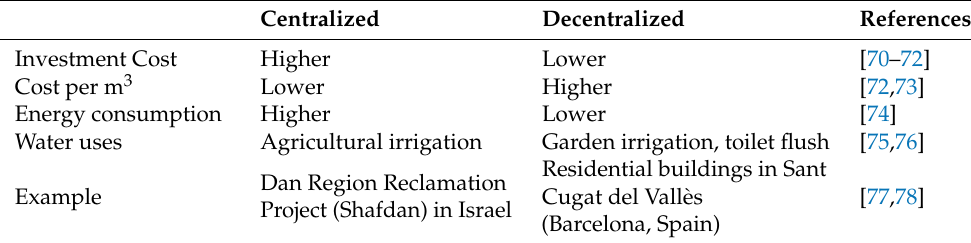
Table 1. Comparison between centralized and decentralized greywater treatment systems. Centralized